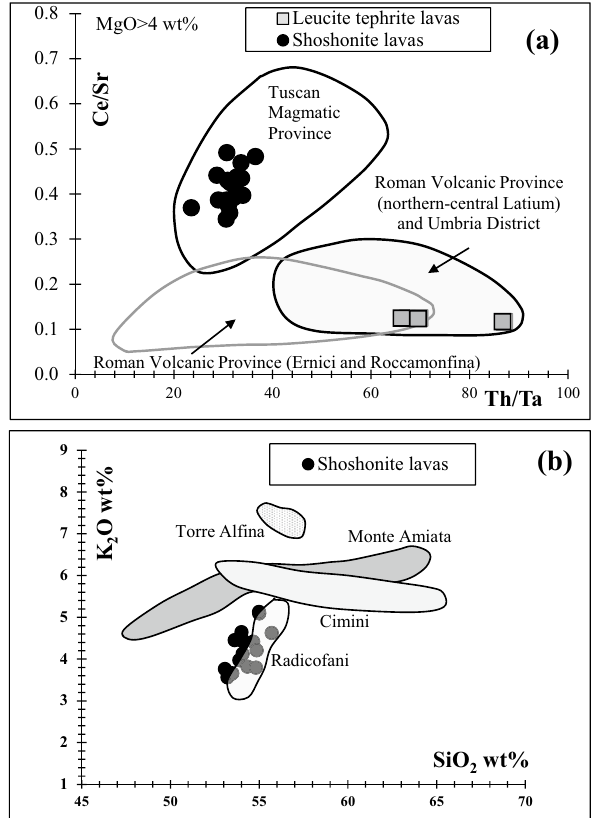
Figure 6. Discriminant diagrams Ce/Sr vs Th/Ta 79 ( a ) and K 2 O vs SiO 273 ( b